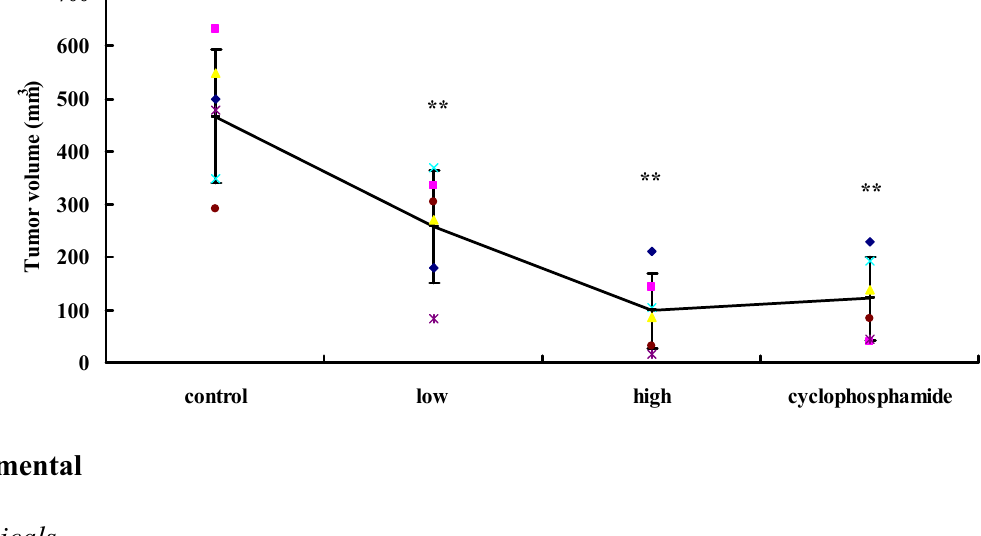
Figure 5. Effect of UA on tumorigenesis of lung tumor cells in vivo : normal control group, experimental group treated with 2.5 mg/kg/day and10 mg/kg/day UA and cyclophosphamide positive control group (n = 6). ** p < 0.01 vs . Control